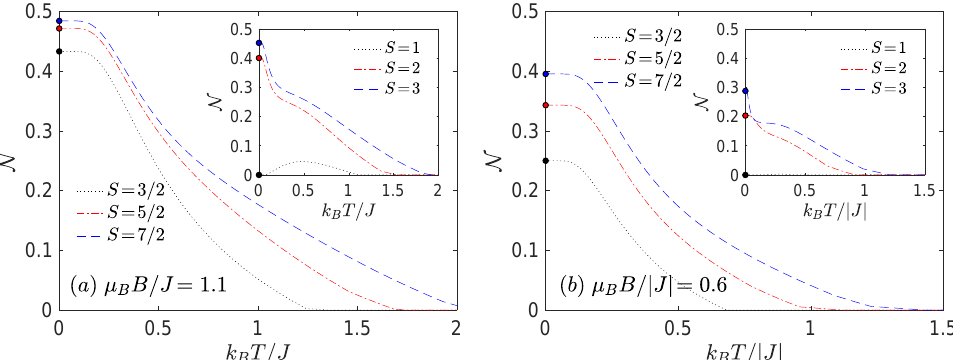
Figure 5. The thermal dependence of the negativity for a few different values of spin magnitudes S calculated at D / J = 1 and ( a ) µ B B / J = 1.1, J > 0 or ( b ) µ B B / | J | = 0.6, J < 0. The choice of model parameters corresponds to the region where the ground state | ( 1 ) ± (cid:105) (half-odd-integer spin S ) or | ( 3/2 ) ± (cid:105) (integer spin S ) are favoured. In case of S = 1 the | S + 1/2 (cid:105) ground state is realized in both